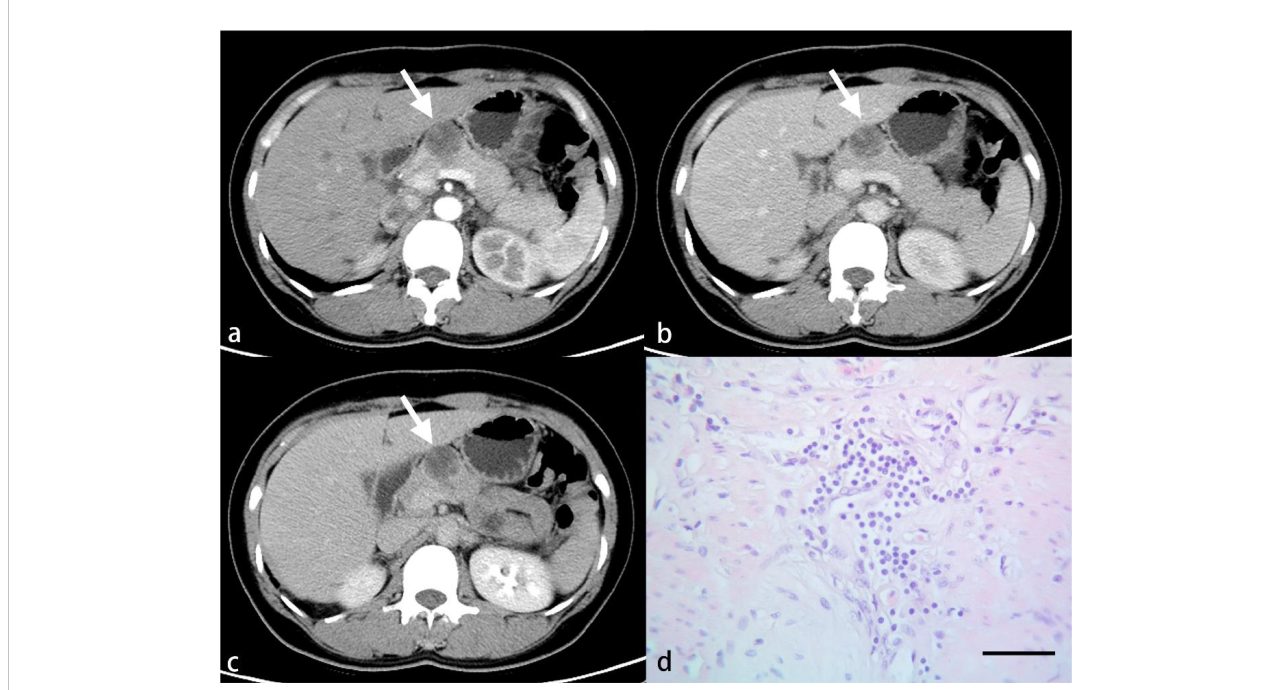
FIGURE 5 A 46-year-old woman with PDAC. Arterial (A) , venous (B) and delayed (C) phase CT images show a well-de fi ned mass in the neck of the pancreas (arrow). A larger number of in fl ammatory cells that formed a band-like in fi ltrate are observed under light microscopy (D) . (HE, scale bar=50 m